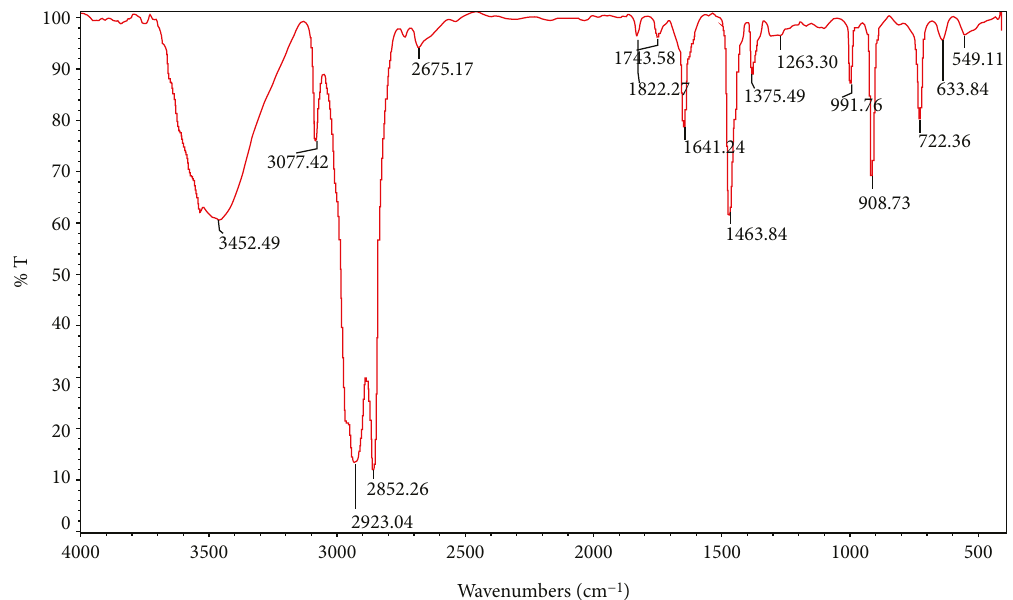
Figure 4: Experimental ZEA IR spectrum. Reproduced with the authorization of Universal Research Publications [48].